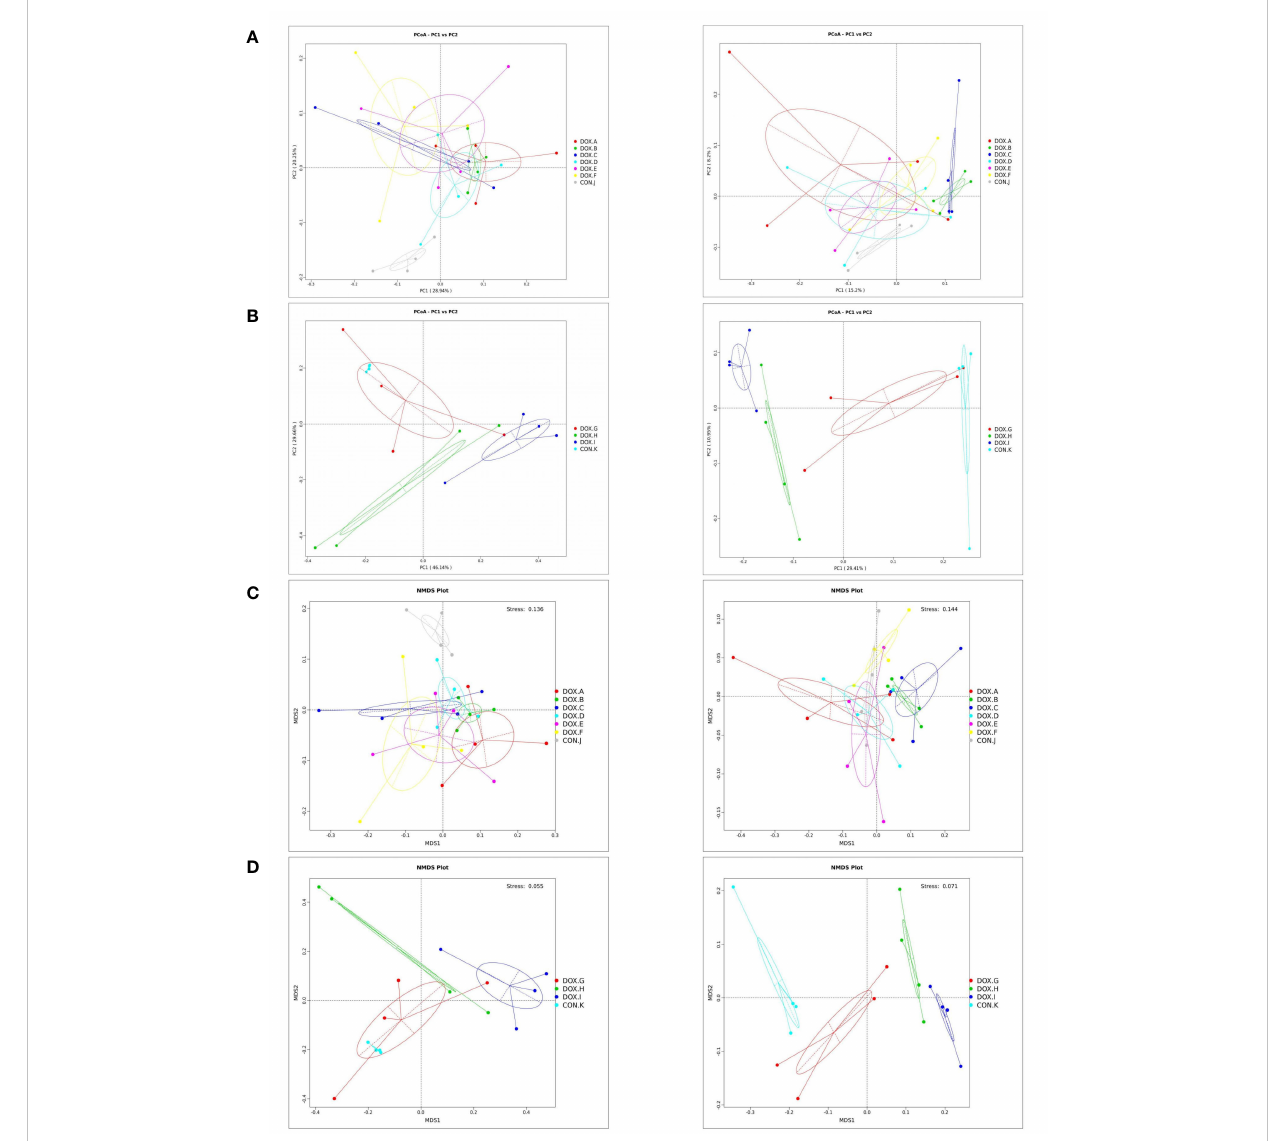
FIGURE 7 Cluster analysis by PCoA and NMDS analysis of the gut microbiota. (A, B) PCoA of weighted and unweighted unifrac distances. PCoA1 and PCoA2 represented the contribution of principal components to sample differences.*The more similar the species composition structure, the closer the samples were to each other. Therefore, the samples with high similarity in community structure tended to cluster together, while the samples with very different communities were far apart. (C, D) NMDS of weighted and unweighted unifrac distances. Species information contained in samples were re fl ected in the multi-dimensional space in the form of points, and the distance between points re fl ected the degree of difference between different samples, which can re fl ected the inter-group and intra-group differences of samples. Stress < 0.2 can accurately re fl ect the degree of difference between samples. CON, control; DOX, doxorubicin; PCoA, Principal Co-ordinates Analysis; NMDS,Non Metric Multi Dimensional